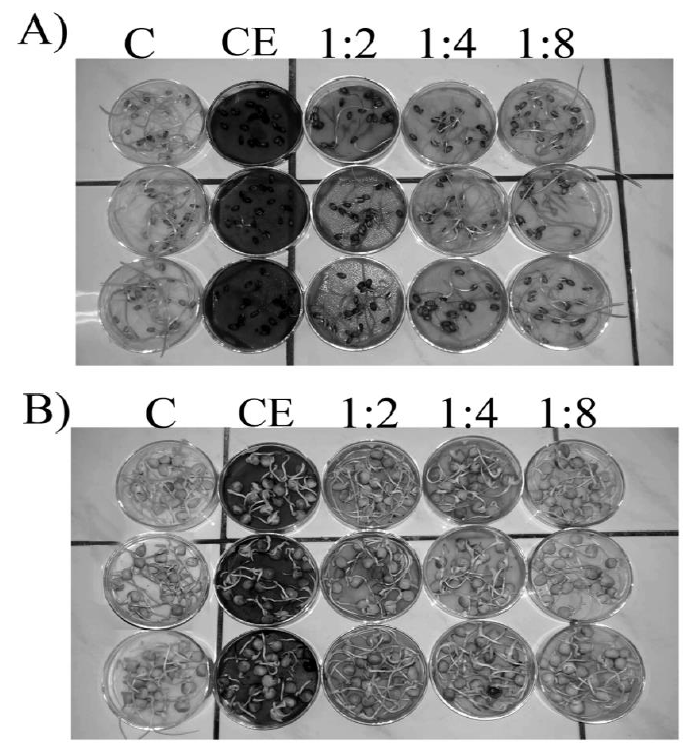
Figure 1. Allelopathic effect of different concentrations walnut leaf aqueous extract on seeds of wheat (A) and pea